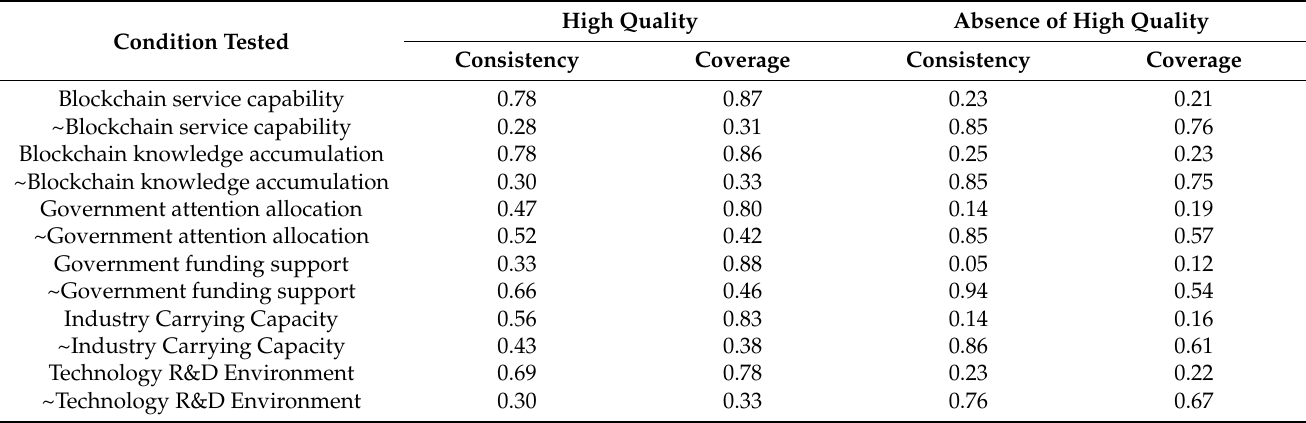
Table 4. The necessity of conditions for high and non-high digital economy quality.